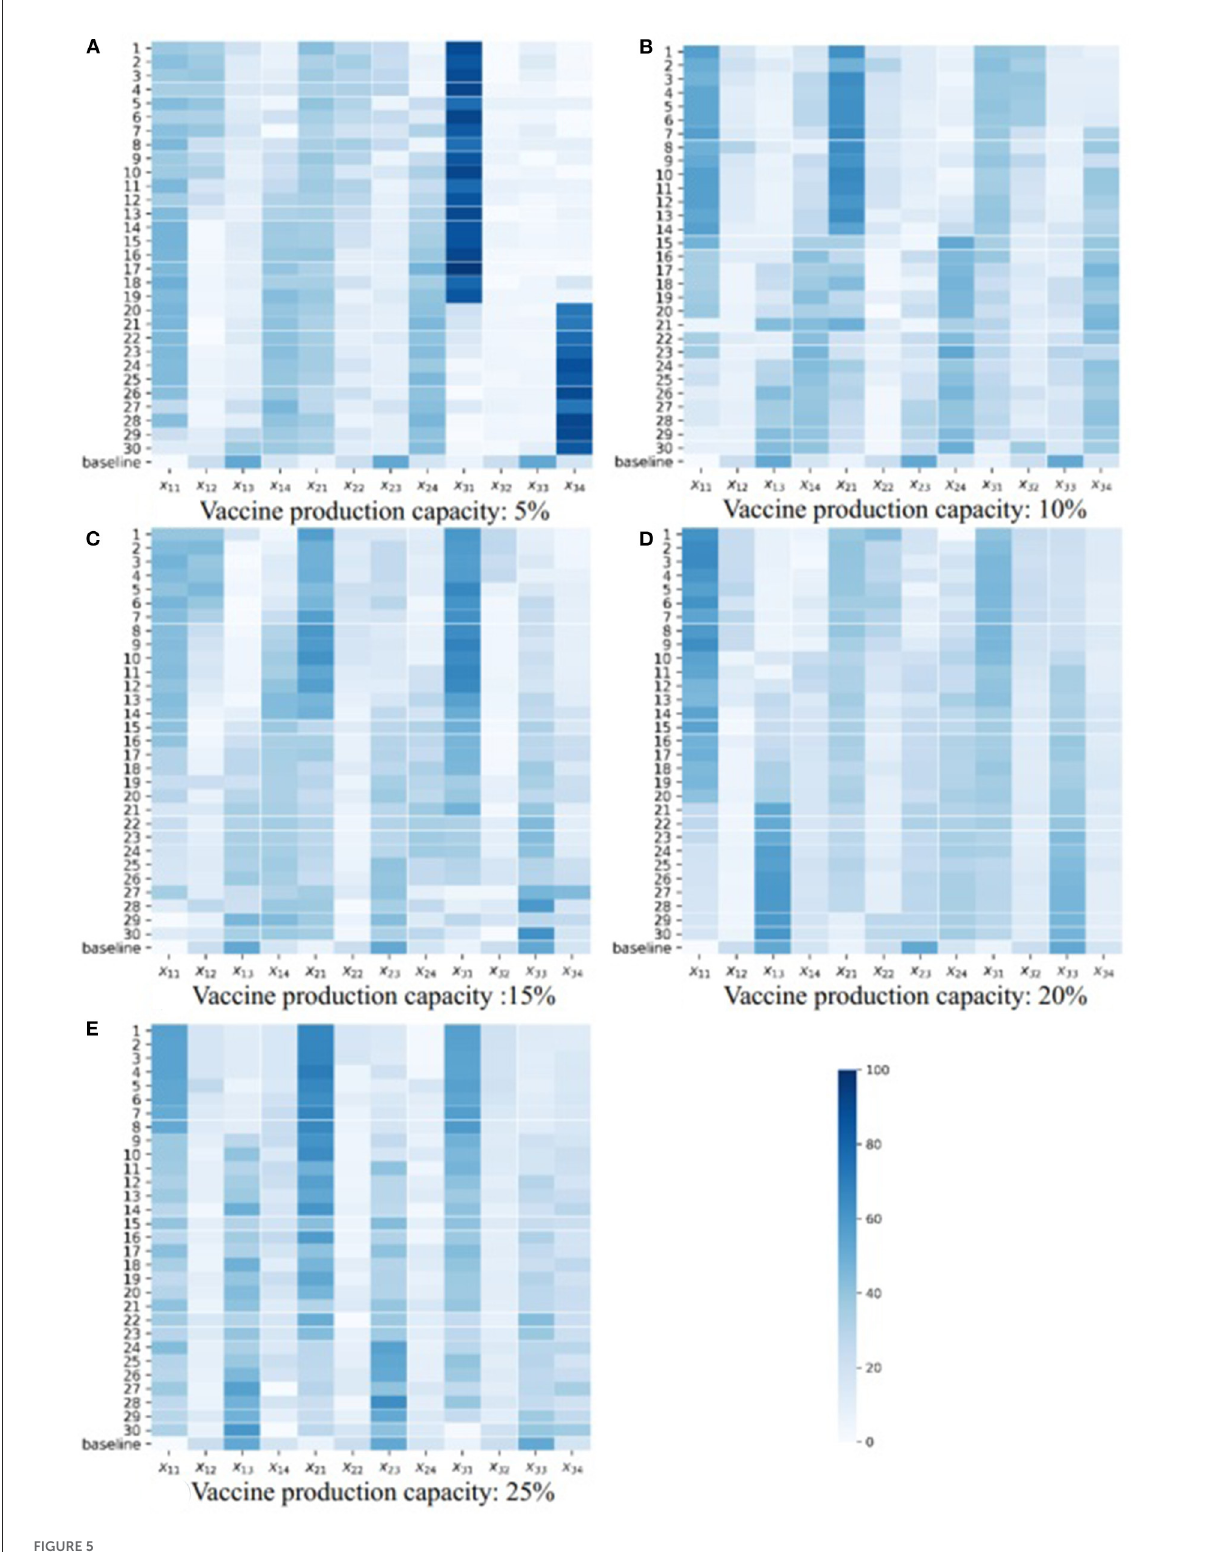
FIGURE5 Heatmaps of Pareto optimal solutions when V e = 10 %